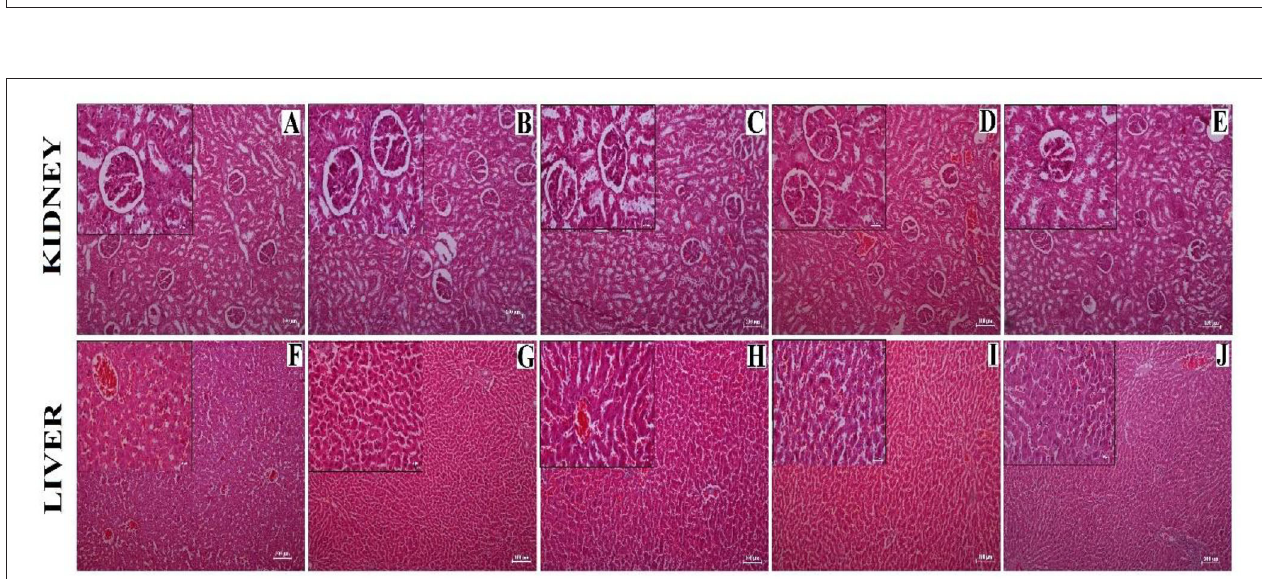
FIGURE 6 | Liver lipid parameters of different experimental rats. Analysis was done by One-way ANOVA followed by Dunnett’s post-hoc test where ***indicates p ≤ 0.001, **indicates p ≤ 0.01, and *indicates p ≤ 0.05. All data represented as mean ± SD of 6 animals. (A) Cholesterol (liver). (B) Triglycerides (liver).